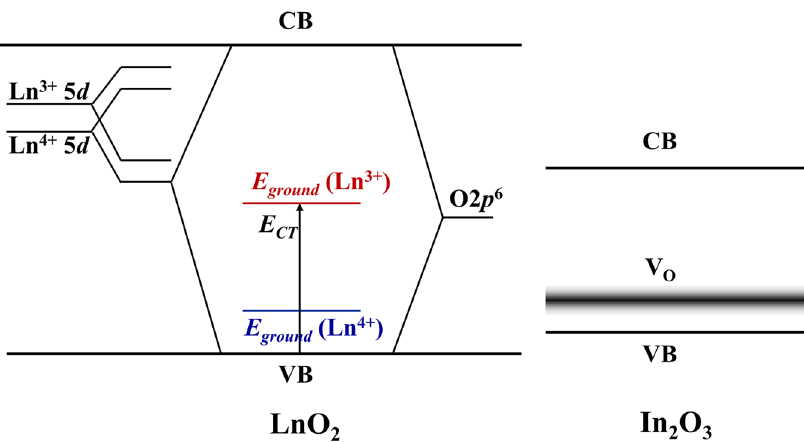
Fig. 7 The schematic diagram of energy levels of the tetravalent lanthanide oxides and In 2 O 3 . The valance band (VB) and the conduction band (CB) were formed by bonding orbitals and antibonding orbitals consisted of the Ln5 d orbitals and the O2 p orbitals in lanthanide oxides.